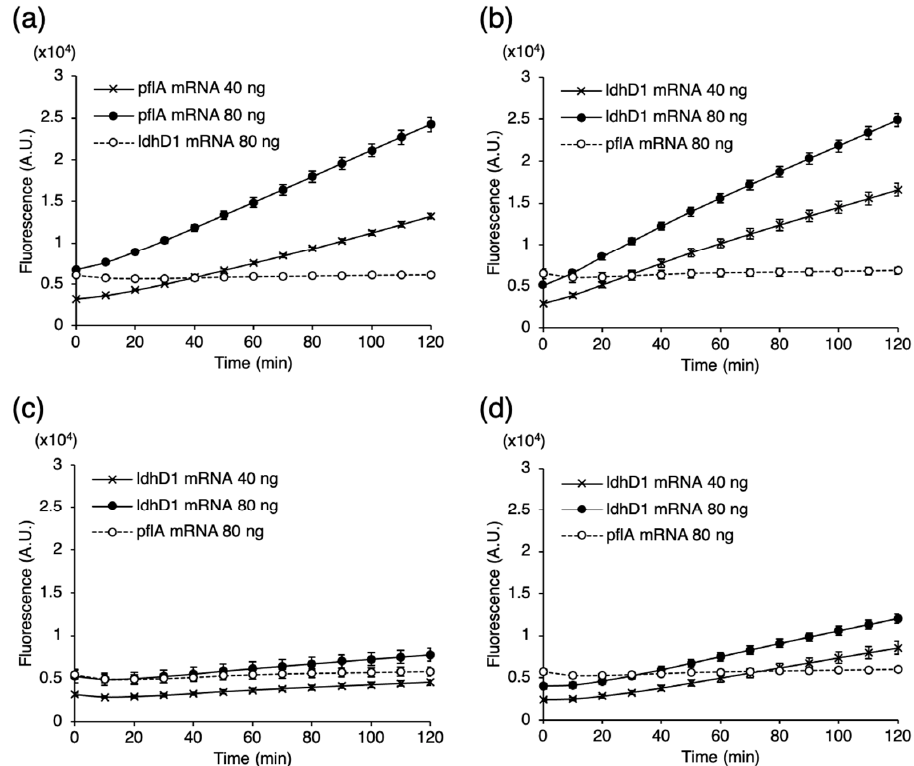
Figure 4. Comparison of the detection sensitivity of PLP- ldhD1 by real-time RHa-RCA. ( a ) Amplification plots of pflA mRNA detection using PLP- pflA . ( b – d ) Amplification plots of ldhD1 mRNA detection using PLP- ldhD1 s; the figures represent Probes #1, #2, and #3, respectively. For each probe, 80 ng of non-target IVT mRNA ( ldhD1 mRNA for PLP- pflA and pflA mRNA for PLP- ldhD1 ) was used as a negative control.